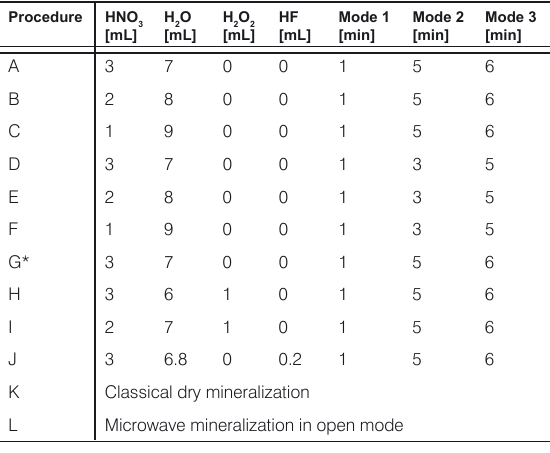
Table 1. The mineralization parameters used in the